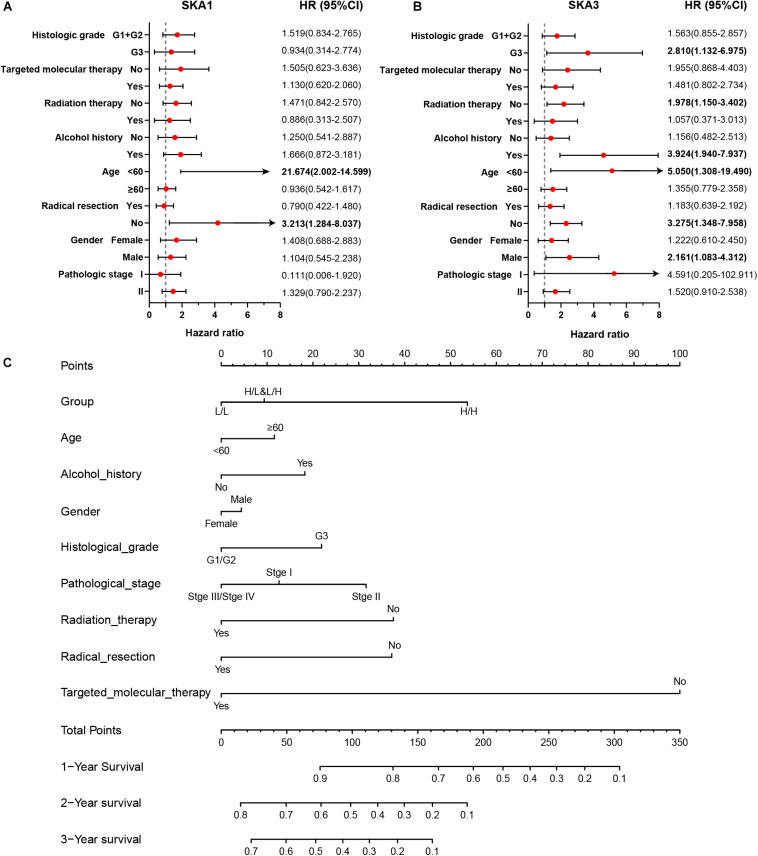
The relationship of spindle and kinetochore-associated genes with the clinical information. (A,B) Stratified survival analysis of SKA1 and SKA3 in various clinicopathological parameters. (C) A prognostic nomogram based on SKA1 and SKA3 for predicting the 1-, 2-, and 3-year overall survival rate of patients with pancreatic ductal adenocarcinoma. HR, hazard ratio; CI, confidence interval; L/L: SKA1low + SKA3low; L/H: SKA1low + SKA3high; H/L: SKA1high + SKA3low; H/H: SKA1high + SKA3high.